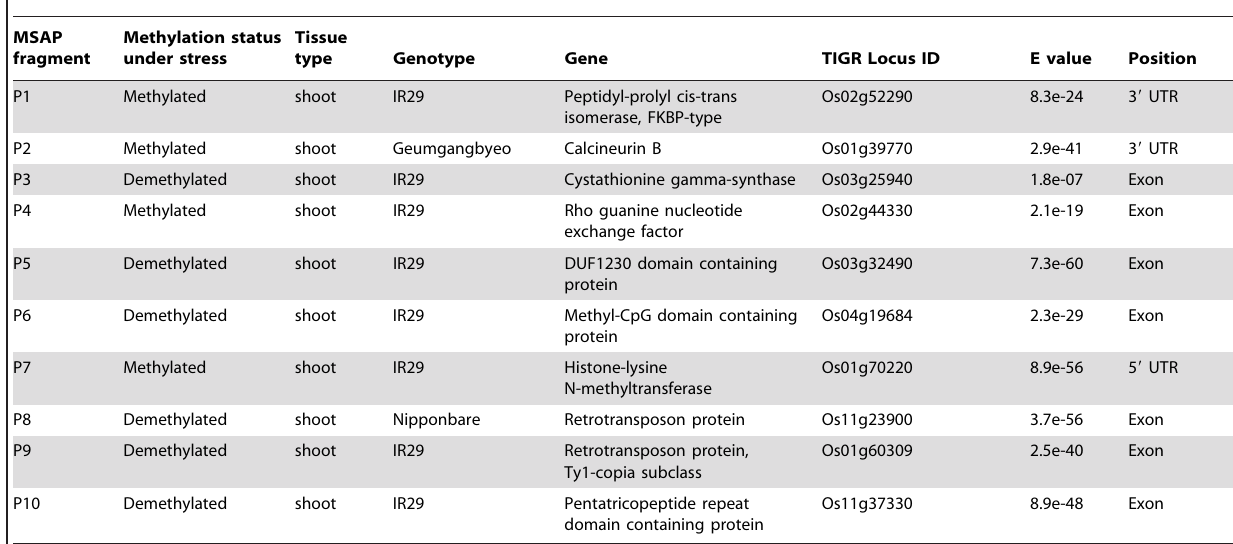
Table 3. BLAST results of ten randomly selected polymorphic methylated fragments and their location on rice genome.